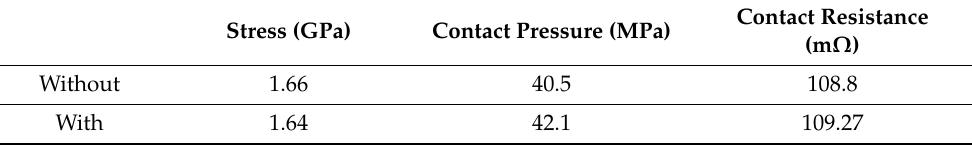
Figure 14. Schematics of ( a ) the motion tendency of CMI with the electrothermal effect and ( b ) the simulated time-varying contact resistance of the optimized CMI. Table 3. Comparison of the parameters with and without the thermoelectrical effect.